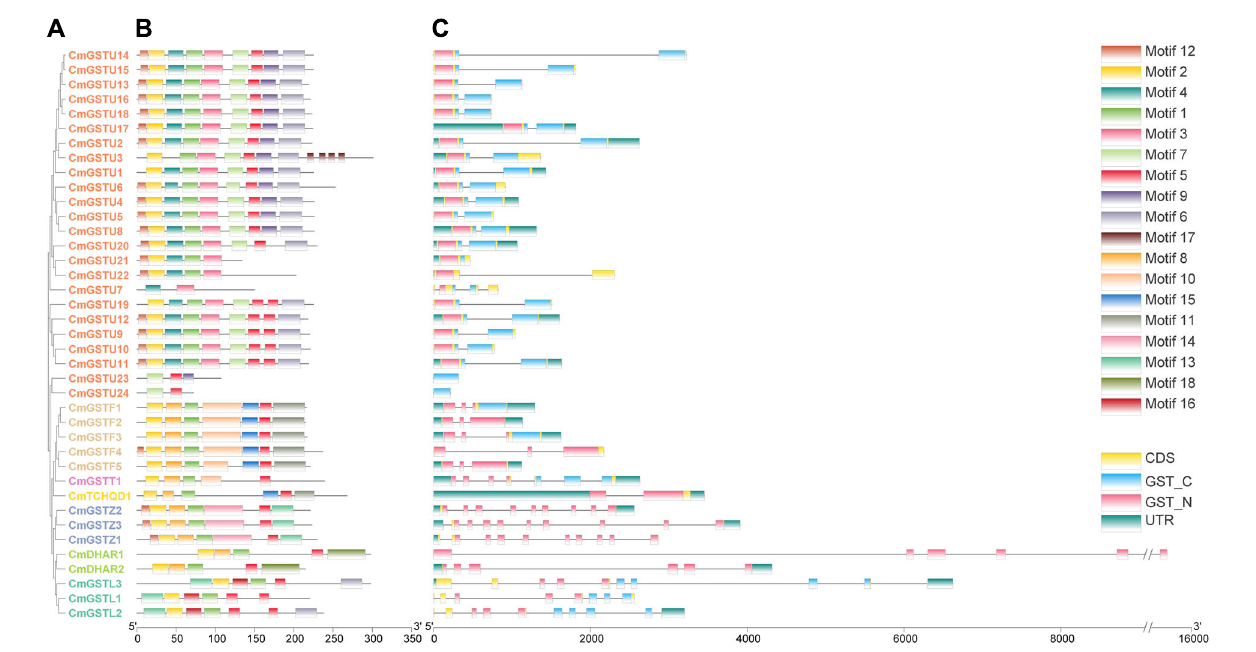
FIGURE 4 | Phylogenetic relationships, conserved amino acid motifs, and gene structures of GSTs from Hami melon. (A) The phylogenetic tree of 39 Hami melon GST genes based on their deduced amino acid sequences. (B) Distributions of conserved amino acid motifs in CmGST genes. (C) Exon-intron organizations of CmGST